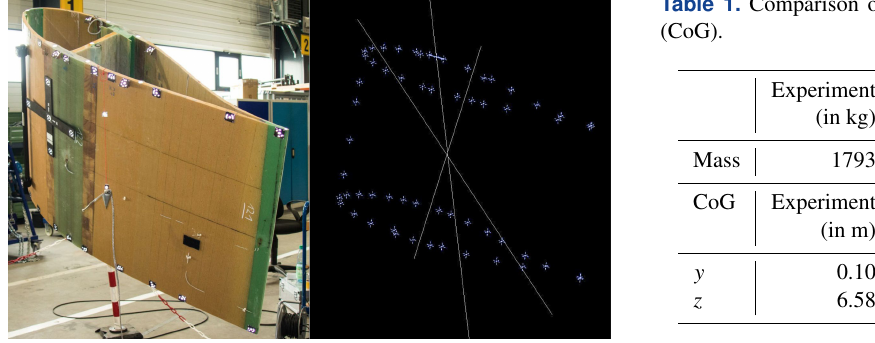
Figure 10. Measurement setup of cross-sectional analysis (left) and extracted vectors in CAD with intersection point defining the center of gravity (right).